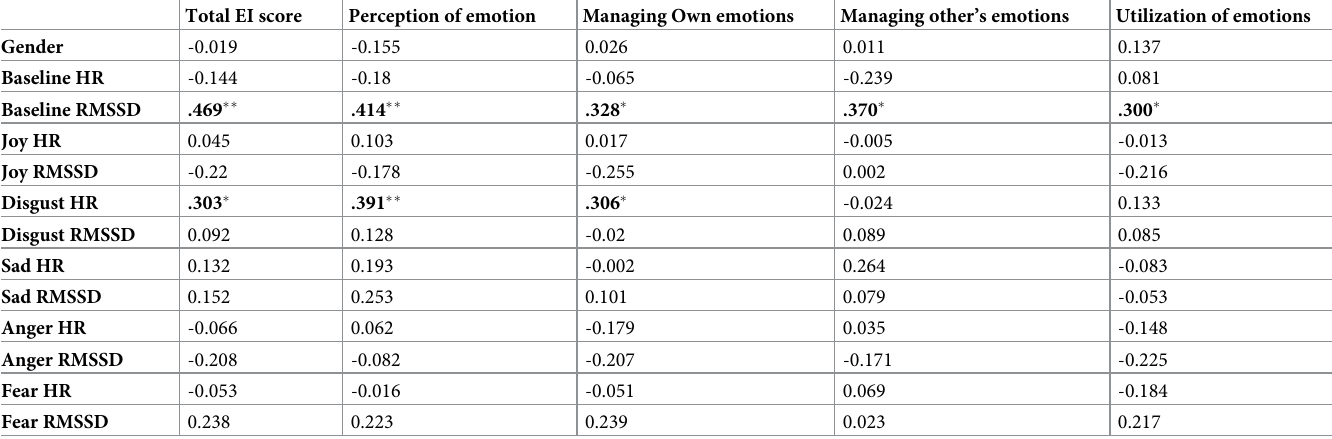
Table 10. Pearson correlation between cardiac response parameters and emotional intelligence scores.